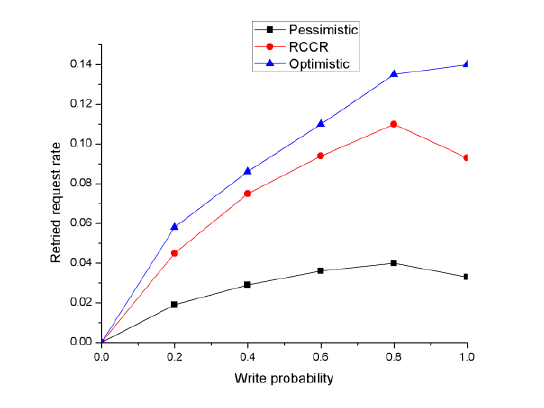
Figure 6. Comparison of retried request